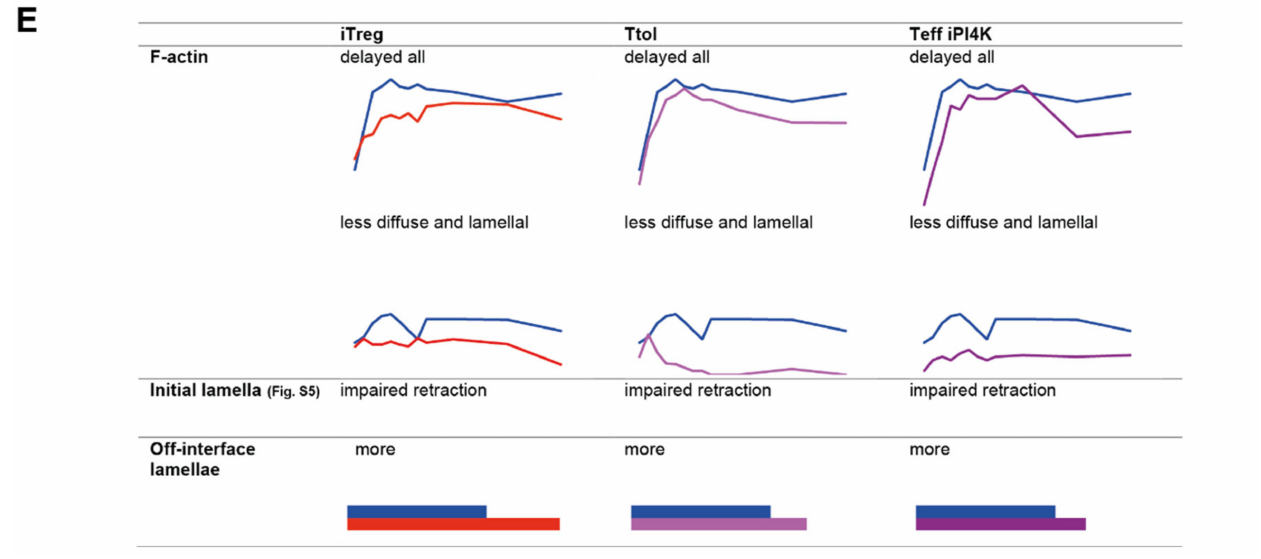
Figure 5. Actin-driven formation of a polarized cell couple is impaired upon induction of a regulatory phenotype. Tg4 T cells as indicated transduced to express F-tractin-GFP were activated with PL8 APCs (10 µ g/mL Ac1-9[4Y]). ( A ) Representative F-tractin-GFP imaging data as in Figure 2A. A corresponding video is available as Video S7. ( B , C ) Data are expressed as the percentage of cell couples with F-tractin-GFP accumulation in the indicated patterns (Supplementary Figure S2A) relative to tight cell couple formation. Number of cell couples analyzed are n = 76, 38, 49, 38 for Teff pep, Ttol, iTreg pep, Teff 9608 cells, respectively, from 2–6 independent experiments. Statistical significance of differences between conditions is given in Table S5; ( B ) All patterns for each cell type separately; ( C ) accumulation in any pattern (left) and in the diffuse and lamellal pattern (right) in direct comparison between the cell types. ( D ) The same data are expressed as the percentage of Tg4 T cells with off-interface lamellae, cumulative up to the indicated time relative to tight cell coupling. Some data points are slightly nudged to increase legibility. ( E ) Changes in accumulation phenotypes of the different Tg4 cell types with regulatory capability in comparison to Teff cells are summarized across all experiments with a cytoskeletal focus of the